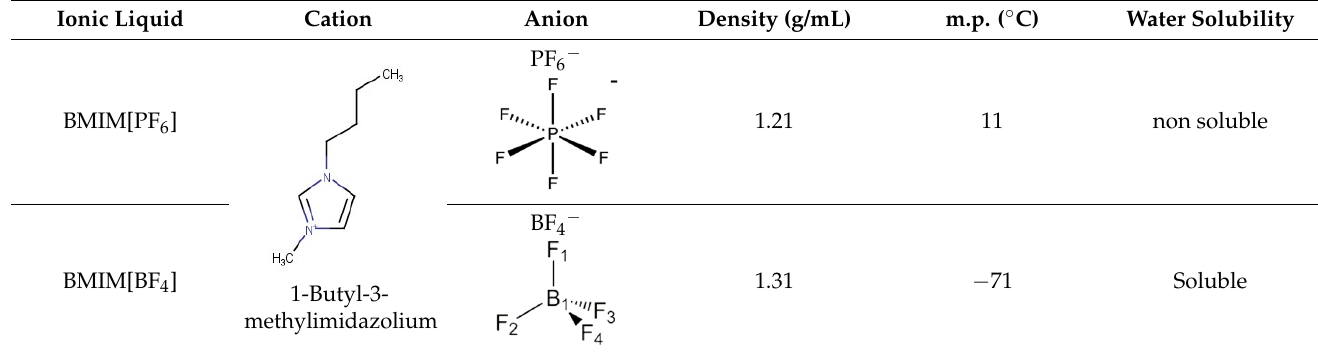
(Table 1). For the purpose of the experiment, the non-soluble ionic liquid BMIM[PF 6 ] was dissolved in a small quantity of about 1 mL of acetonitrile and mixed in the mobile phase. Table 1. Structure and properties of the ionic liquids used in the presented study.